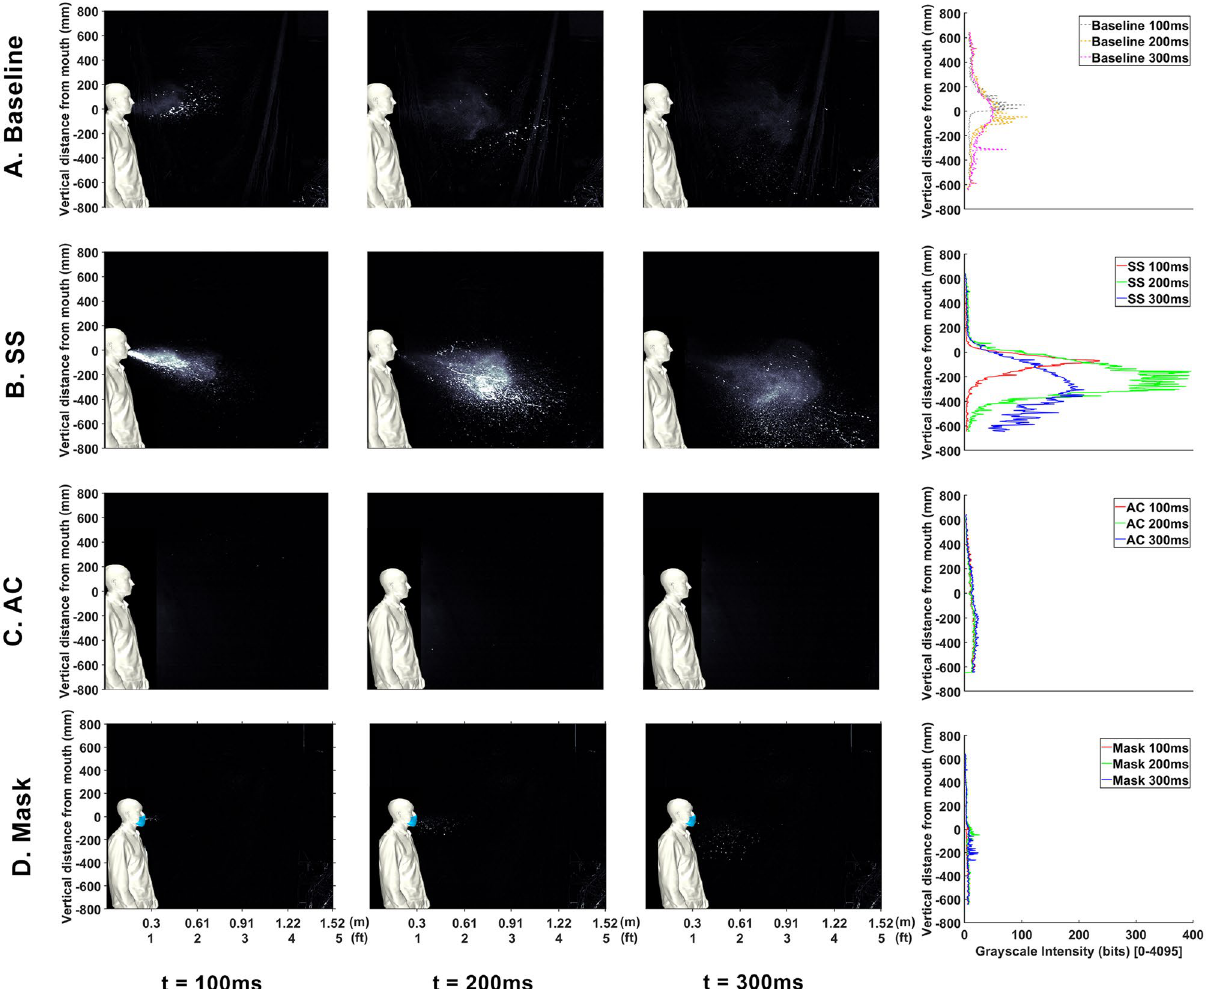
Figure 5. High-speed photography from human sneeze. Cases compare ( a ) baseline, ( b ) SS (sugar-based cough drop), ( c ) AC, and ( d ) mask. Each columns represents a different point in time after the